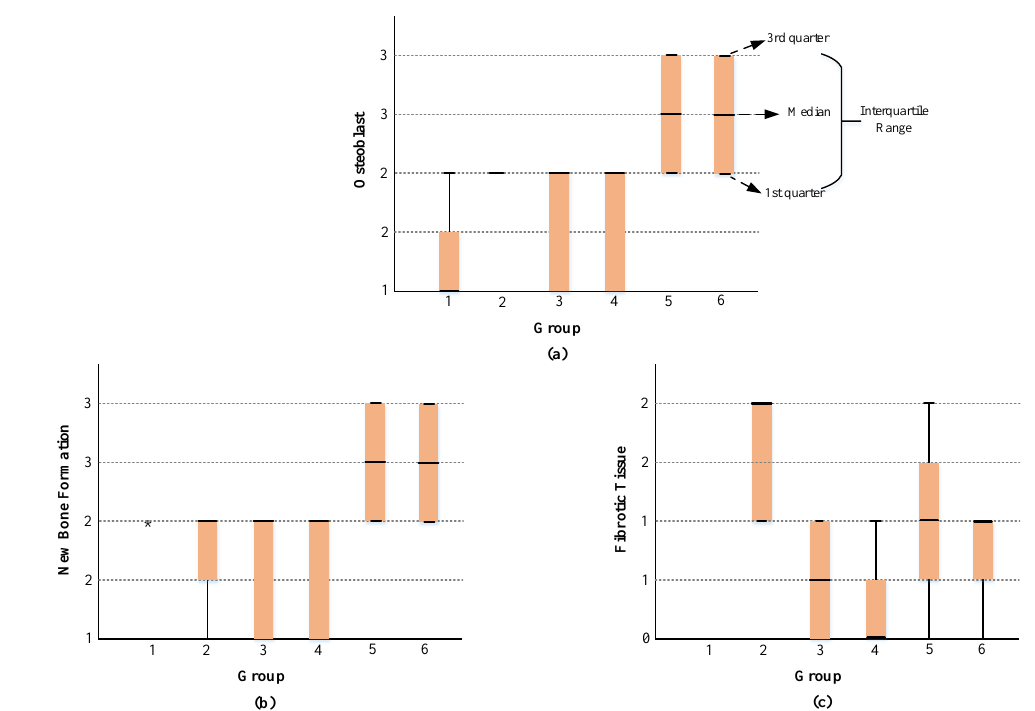
Figure 6. Statistical results of ( a ) osteoblast, ( b ) new bone formation, and ( c ) fibrotic tissue. (* = Extreme outlier value).